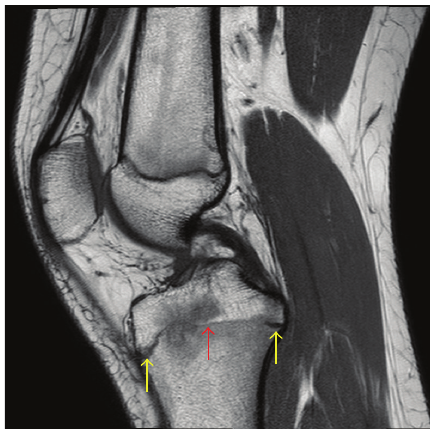
Figure 10: A 13-year-10-month-old female with FOPE zone of the distal right femur. Findings: presenting radiographs of the knees were normal. There is partial closure centrally of the bilateral proximaltibiaphyses.Thebilateraldistalfemurphysesarenarrowed but remain open. Technique: AP radiograph kVp = 70, mAs =